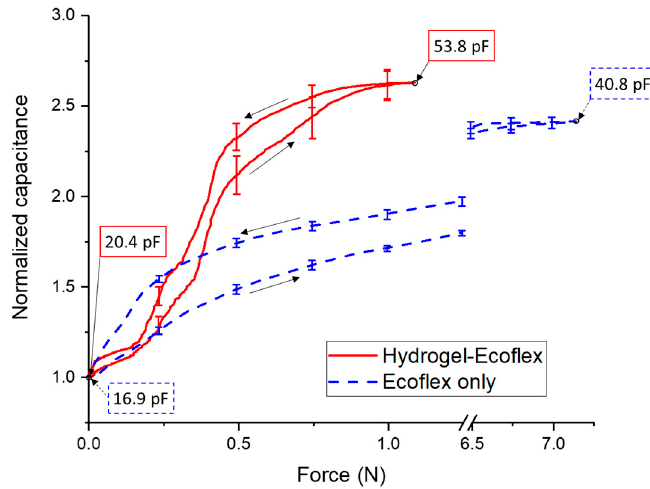
Figure 4. Electromechanical characterization of a single sensor/button. The tested button is in the middle/center of the three-by-three grid of the soft layer. The maximum displacement applied in each test was 2.4 mm. The upward arrow shows the compression cycle, and the downward arrow shows the release cycle. To make a meaningful comparison between the two cases (Ecoflex and hydrogel-Ecoflex hemispheres), there is a break in the x-axis from 1.25 N to 6.25 N. The plotted results are the average values of five repeated tests, and the error bars are ± 1 standard deviations shown every 0.25 N. The normalized capacitance is the ratio of the measured value to the initial value. The frequency of excitation on the impedance analyzer was 100 kHz.